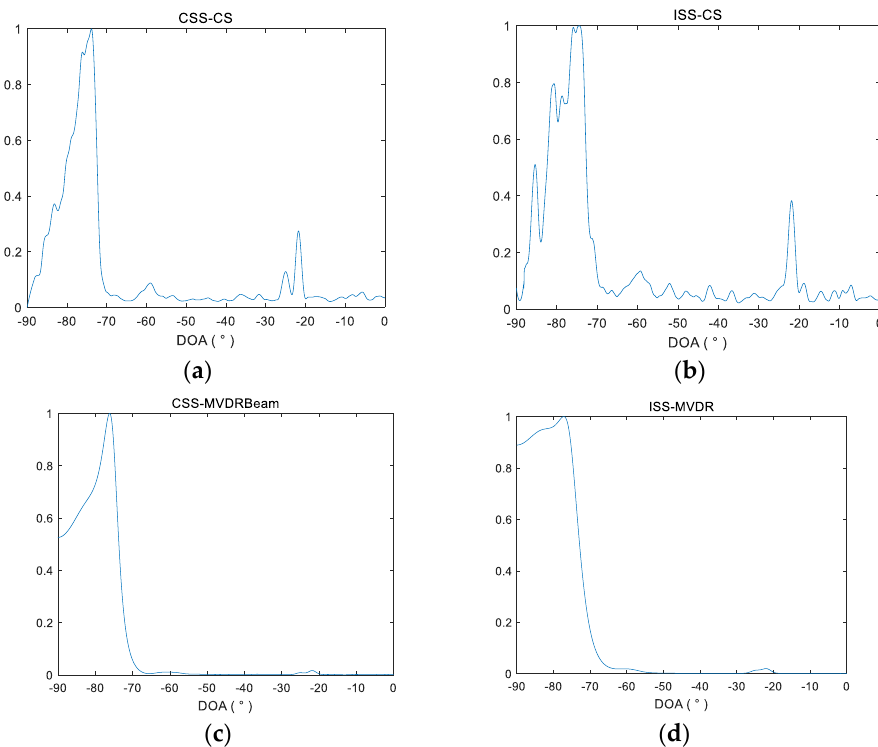
Figure 10. Spatial beam spectra after processing the first second data by four methods. ( a )Spatial beam spectra after processing the first second data by CSS-CS; ( b ) Spatial beam spectra after processing the first second data by ISS-CS; ( c ) Spatial beam spectra after processing the first second data by CSS-MVDR; ( d ) Spatial beam spectra after processing the first second data by ISS-MVDR.